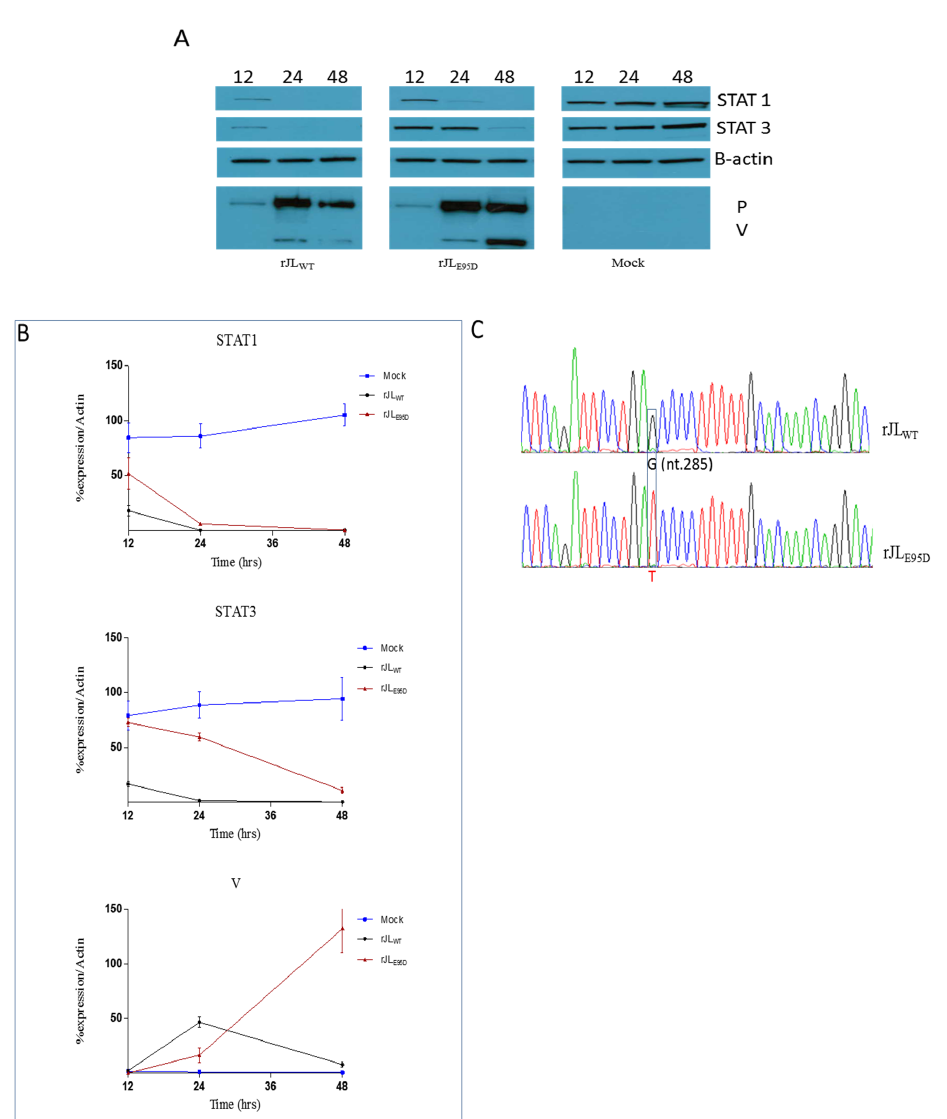
Figure 4. Degradation of STAT proteins in vitro (rJL WT and rJL E95D ). ( A ) Confluent monolayers of Vero cells were infected with rJL WT and rJL E95D at an MOI of 1.0. Cell lysates prepared at the times indicated